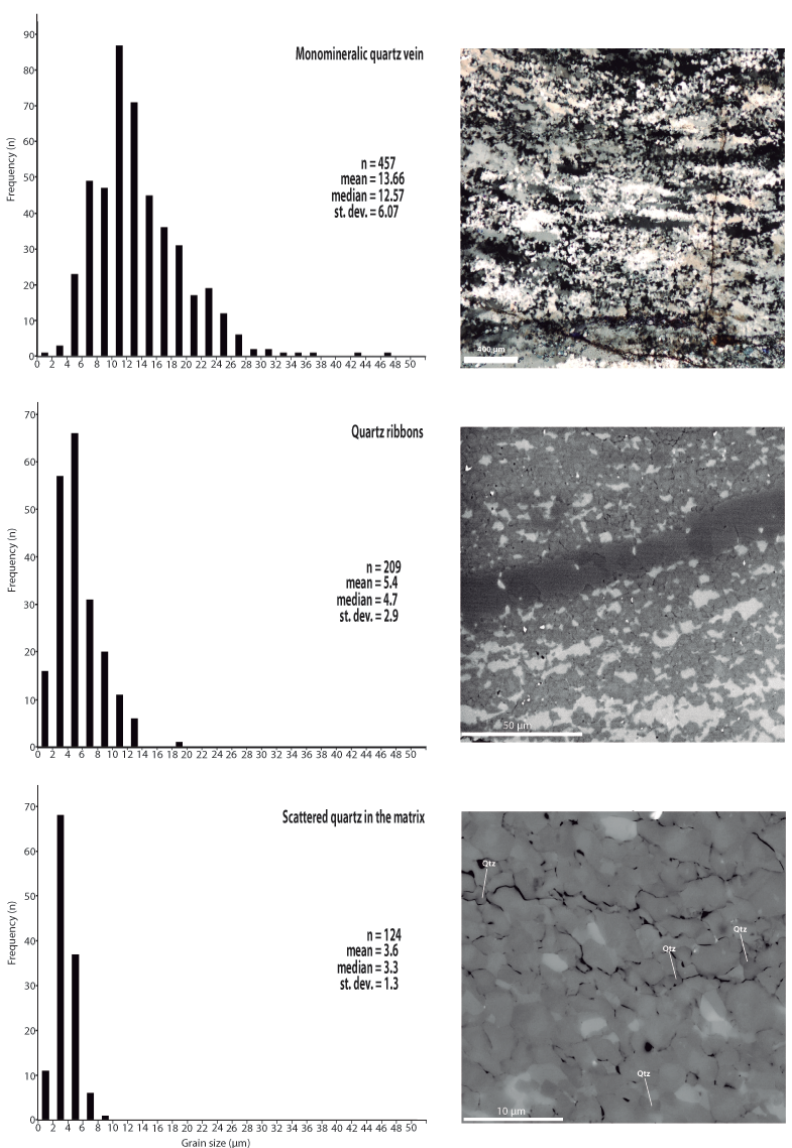
Figure 8. Grain-size histograms for quartz in the different domains – monomineralic veins, ribbons and scattered in the feldspathic